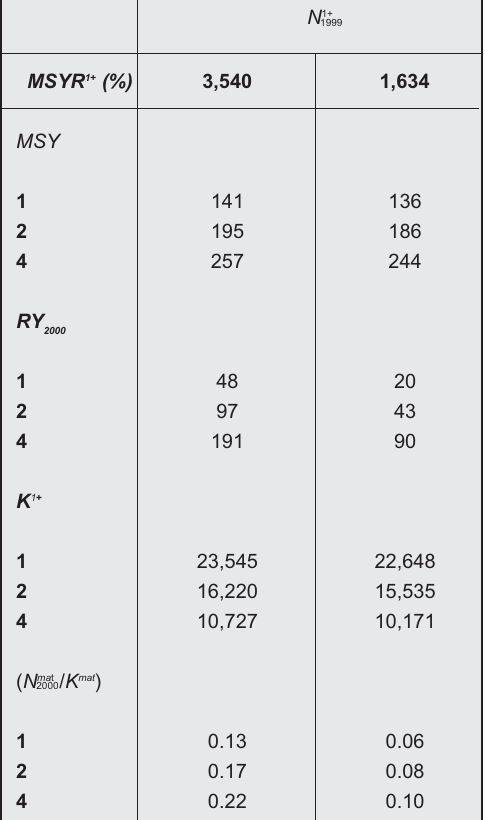
Table 1c . Parameters of population trajecto- ries which hit the best estimate (3,540) and corresponding lower 5%-ile (1,634) total (1+) population sizes in 1999 for various values of MSYR 1+ for the “Lower” stock in the two stock scenario for beluga whales off West Greenland. Results are shown for MSY, RY the pristine (pre-exploitation) total population size ( K 1+ ), and the current status of the mature component of the population relative to pris- tine ( N ma t / K mat